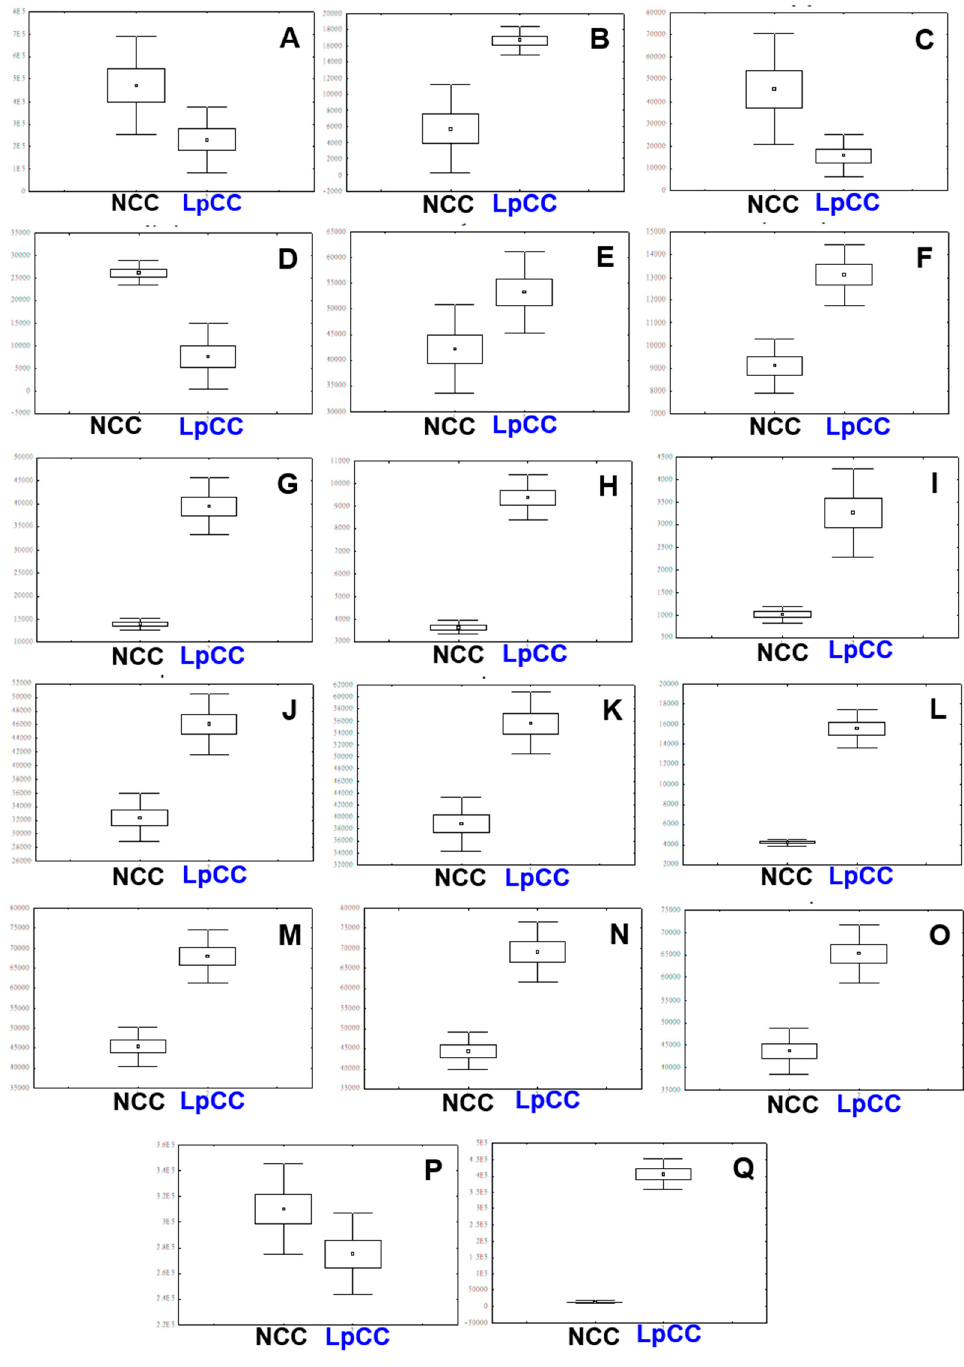
Figure 5. Box-and-whisker plots illustrating the relative abundance of metabolite levels (VIP > 0.7, p < 0.05) of NCC and LpCC extracts using UHPLC-LTQ-Orbitrap-MS/MS. ( A ) N-(1-deoxy-1- fructosyl)phenylalanine, ( B ) 3-(2,3,4-trihydroxy-5-methoxyphenyl)propanoic acid, ( C ) glycyrol, ( D